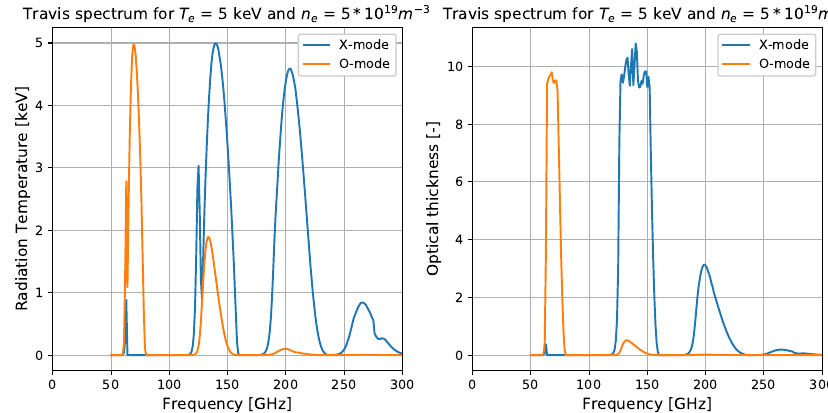
Figure 2: Data from Travis, left: radiation spectrum and right: optical depth.